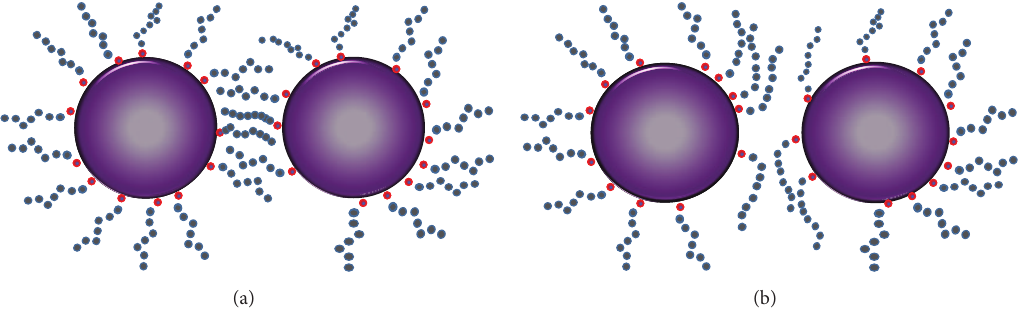
Figure 4: Stabilization of colloidal particles by steric repulsion. (a) Increased local osmotic pressure. (b) Excluded volume effect. Adapted from [3]. Colloidal particles are shown in purple; polymers are the gray chains with red heads.